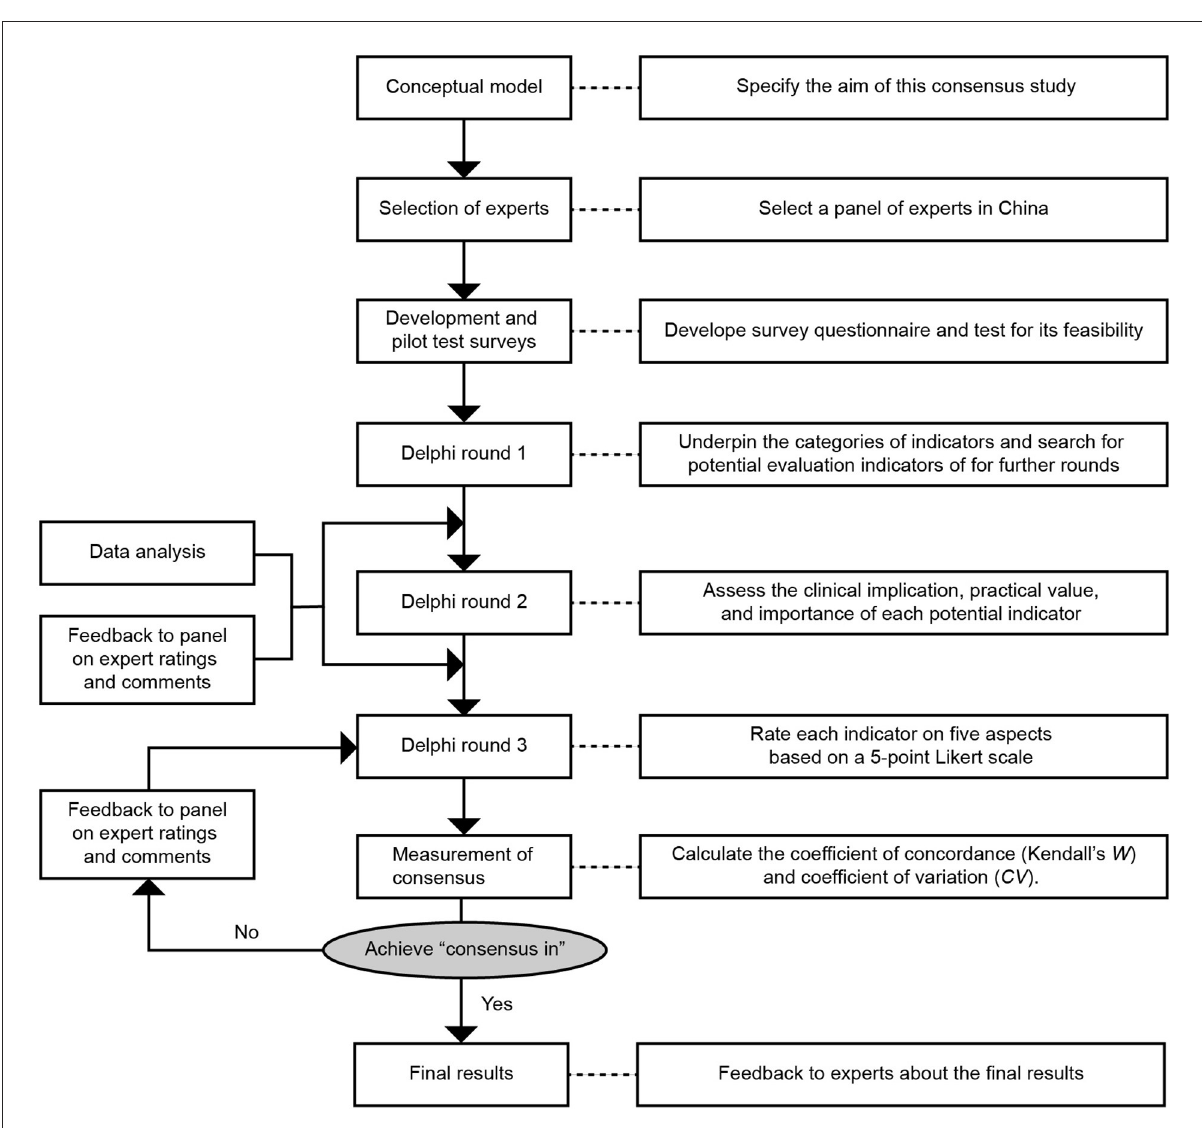
FIGURE1 Process of this Delphi